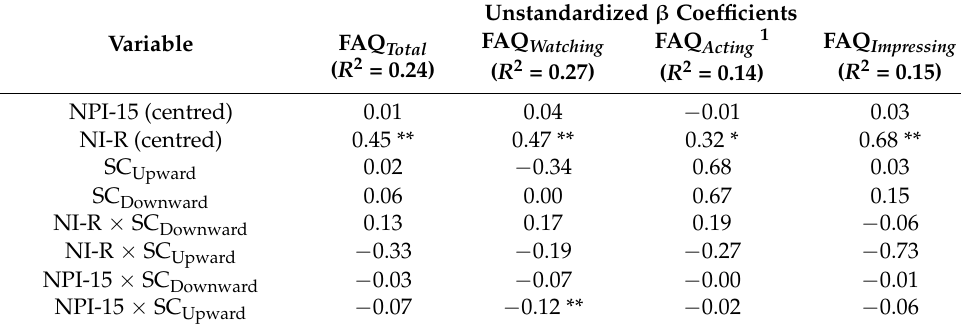
Table 5. Linear model of predictors of FAQ